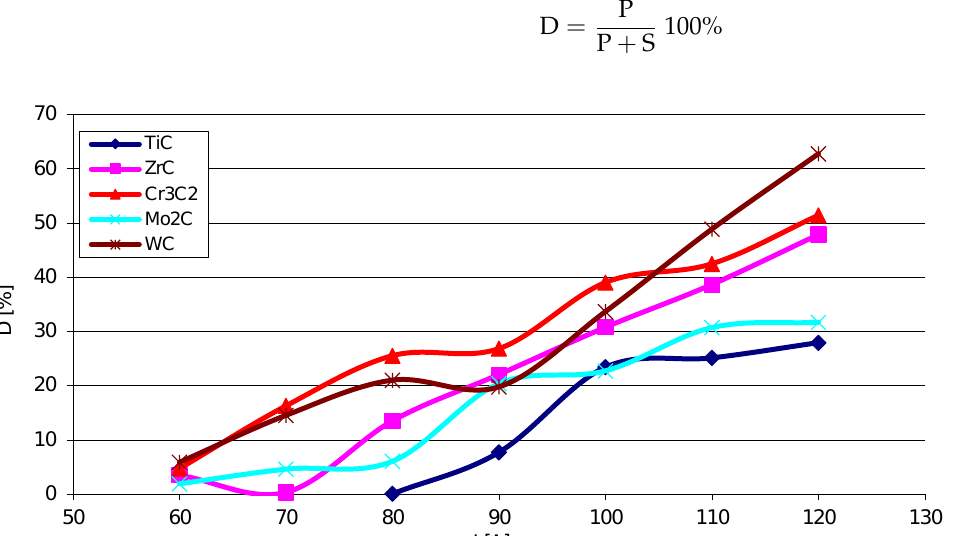
Figure 18. Volume fraction (D) of the substrate material in overlays with particular carbides as a function of the welding current I.